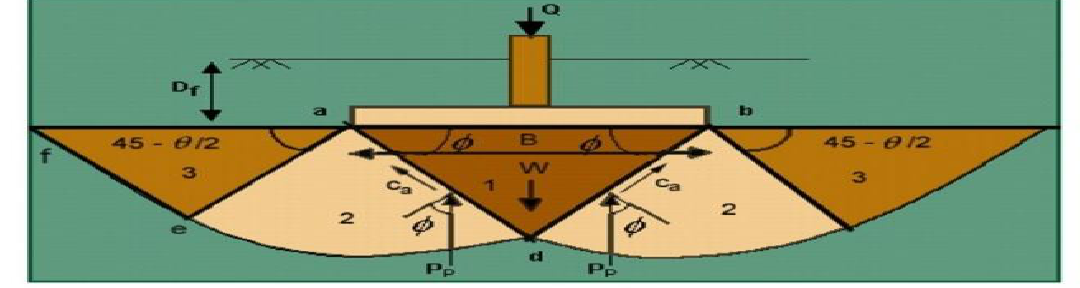
Fig. 2. Terzaghi’s bearing capacity theory